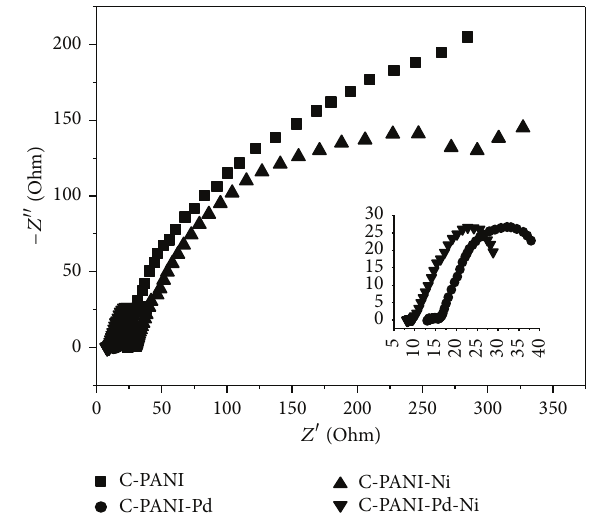
Figure 7: Electrochemical impedance spectra (Nyquist) for metha- nol oxidation on different electrodes in 0.5 M H 2 SO 4 solution con- taining 1.0M methanol at 0.2